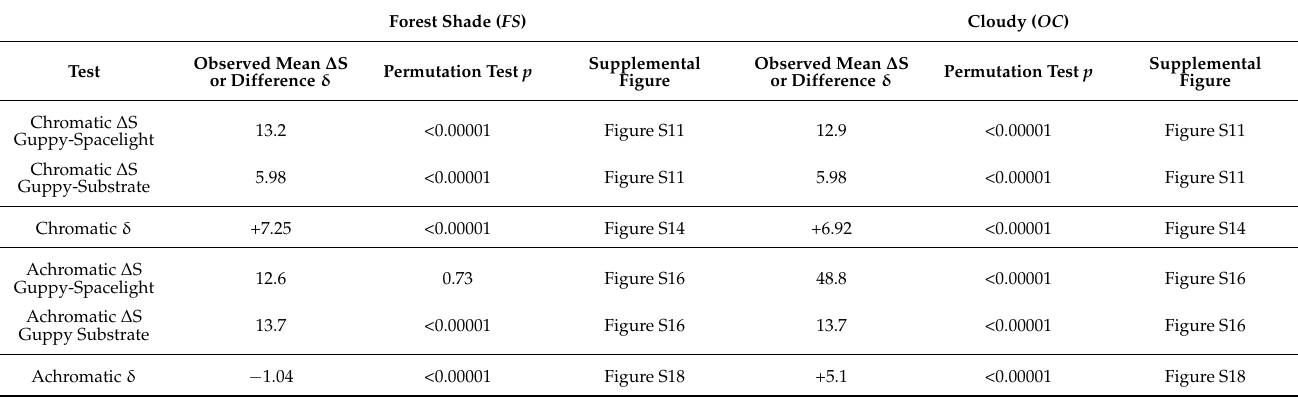
Table 3. Permutation tests for ∆ S between guppy patches and backgrounds (spacelight or substrates) and for differences δ between these two sets of ∆